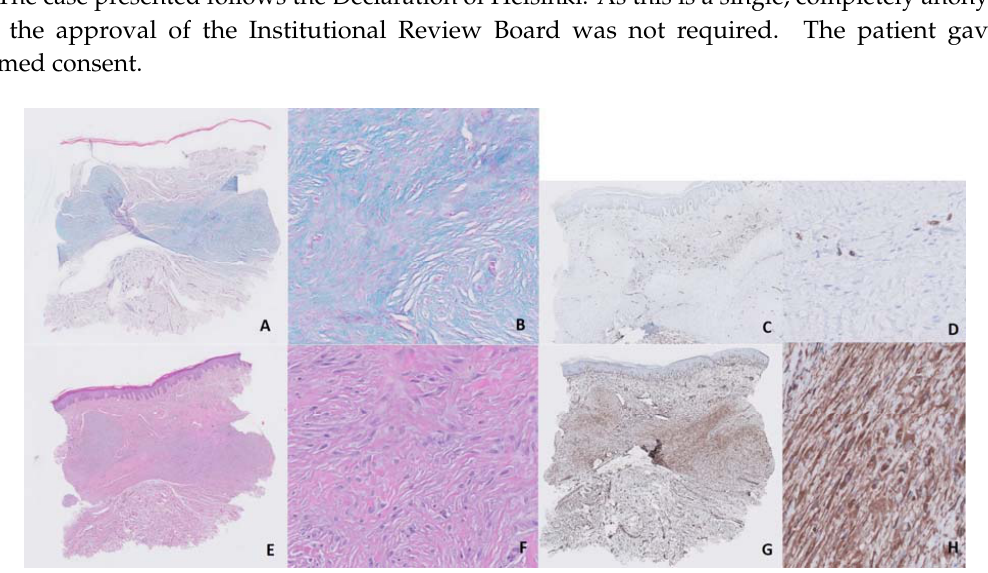
Figure 1. Spontaneous keloids on the chest and breasts of the patient before ( 1A ) and after ( 1B ) the treatment with UVA ‐ 1 phototherapy.